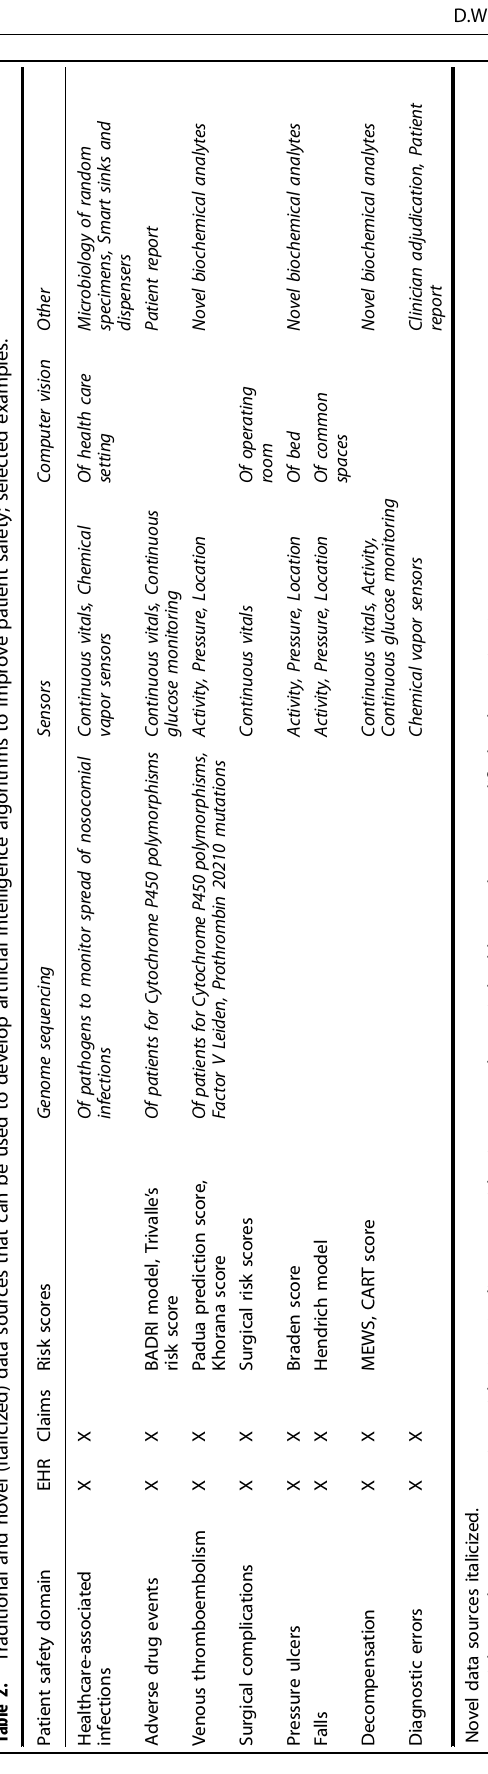
Table 2) that used AI for management of pressure ulcers. To date, most AI research in this area has focused on using sensor data